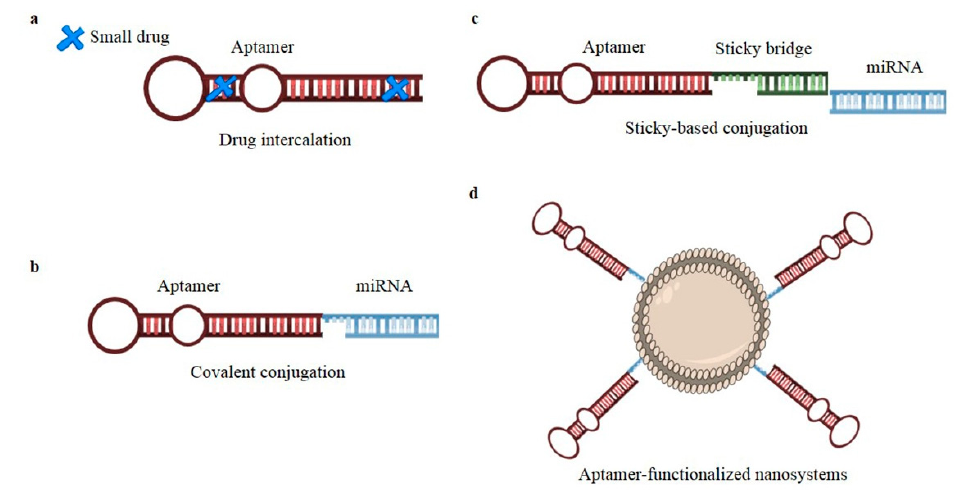
Figure 4. Schematic representation of aptamer-based complexes applied to NSCLC therapy. Aptamer complexes developed for the targeting of NSCLC were generated by: ( a ) direct drug intercalation within the aptamer structure; ( b ) aptamer covalent conjugation to miRNAs in which the aptamer sequence is extended with one of the miRNA strand and then annealed with the other miRNA strand; ( c ) aptamer non-covalent conjugation to miRNAs through a stick-based strategy in which the aptamer and miRNA passenger strand are extended with complementary stick sequences to allow their annealing; ( d ) nanosystem decoration with a targeting